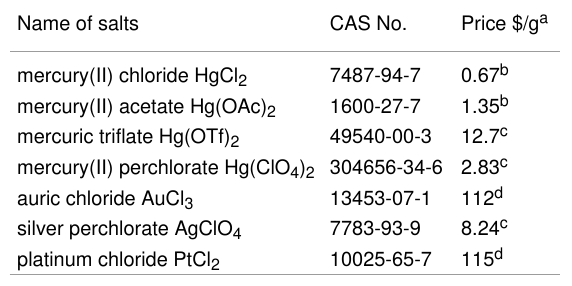
Table 1: Comparison of price of reagent grade Hg(II) salts with other transition metal salts. Name of salts CAS